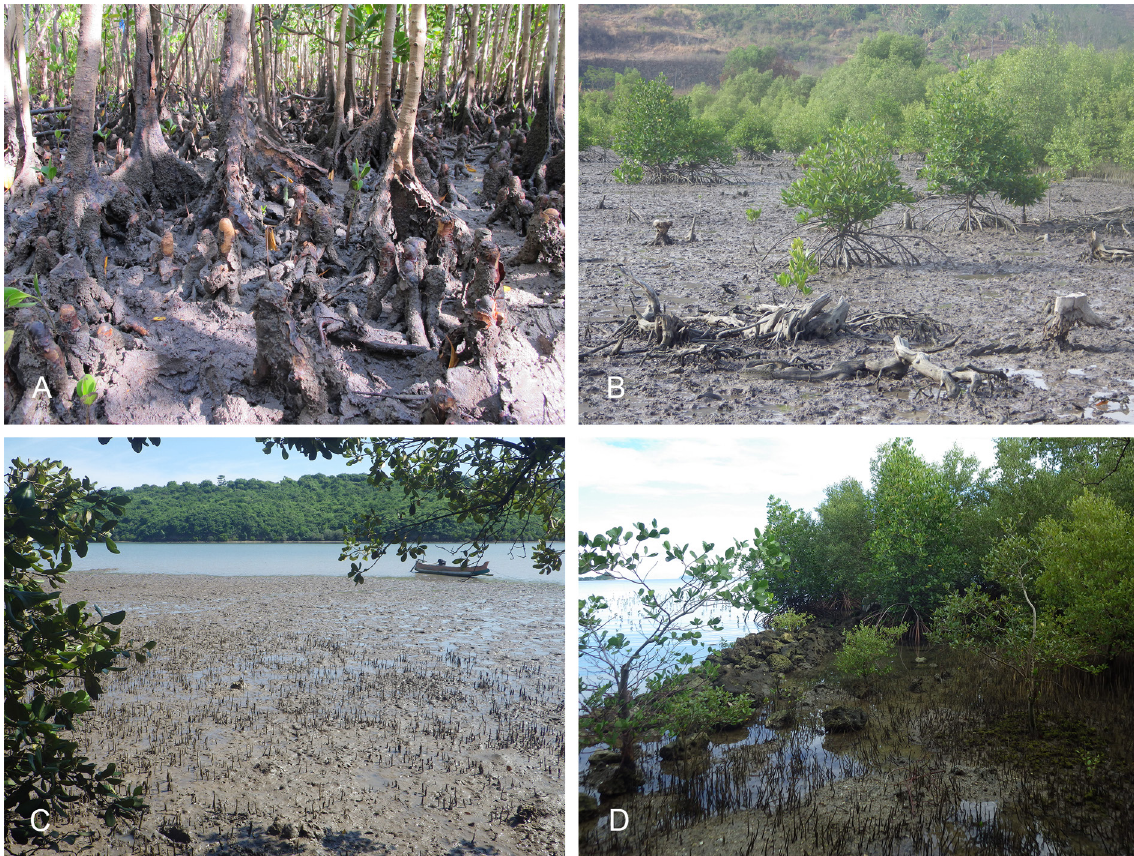
Fig. 25. Paromoionchis tumidus (Semper, 1880) comb. nov. unit #2, habitats. A . Australia, Northern Territory, large mangrove of Sonneratia, Rhizophora and Ceriops (st. 66). B . Indonesia, Sumatra, small patch of mangrove, very impacted (st. 81). C . Indonesia, Lombok, open Avicennia mangrove (station 146). D . Philippines, Luzon, narrow and very sandy Avicennia mangrove, with no mud (st.